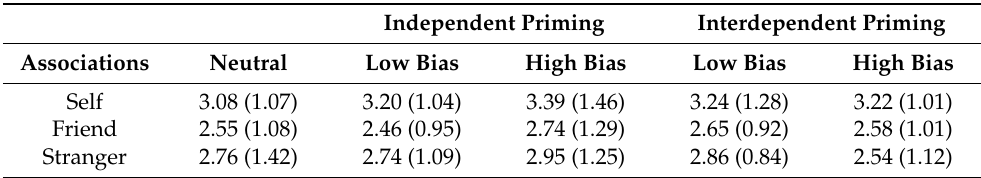
Table 4. Mean d-prime scores and SD (in brackets) as a function of association, priming, and bias group in the Experiment